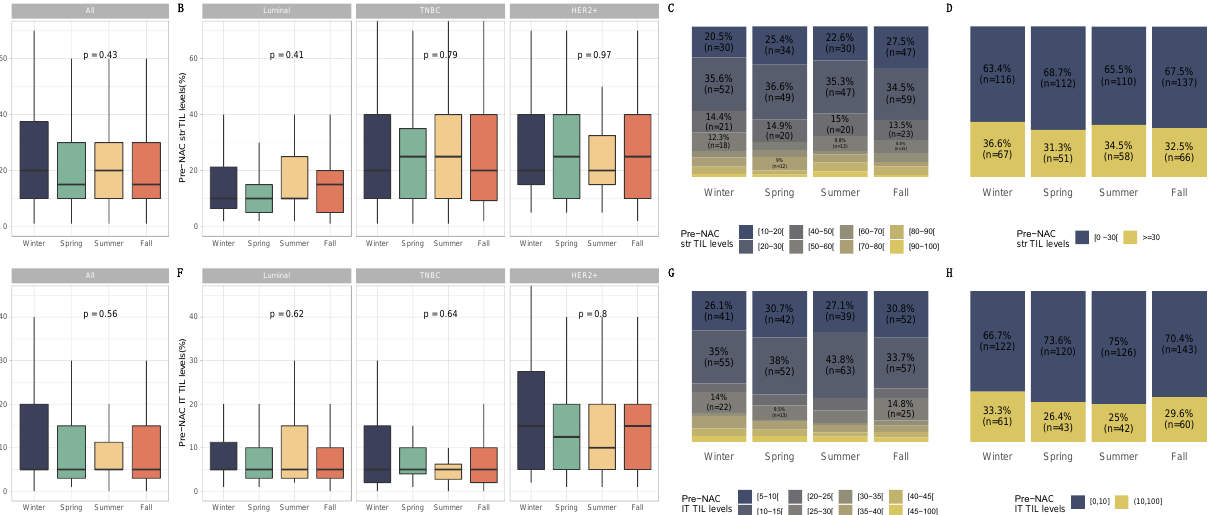
Figure 2. Pre-NAC TILs and season at breast cancer diagnosis in the general population and by breast cancer subtype. BC patients with pre-NAC str TIL levels available [n = 717] and IT TIL levels [717]. The first and third quartiles are represented by the bottom and top bars of the boxplots, respectively; the median is represented by the medium bar; and whiskers extend to 1.5 times the interquartile range. ( A ) Stromal lymphocytes among the whole population. ( B ) Stromal lymphocytes in each BC subtype. ( C ) Pre-NAC stromal lymphocyte counts were binned by 10% increments in patients by season to determine the proportion of tumor. ( D ) Percentage of tumor according to pre-NAC stromal lymphocyte levels binned by Denkert cut-off by season. ( E ) Intratumoral lymphocytes among the whole population. ( F ) Intratumoral lymphocytes in each BC subtype. ( G ) Pre-NAC intratumoral lymphocyte counts were binned by 10% increments in patients by season to determine the proportion of tumor. ( H ) Percentage of tumor according to pre-NAC intratumoral lymphocyte levels binned by Denkert cut-off by